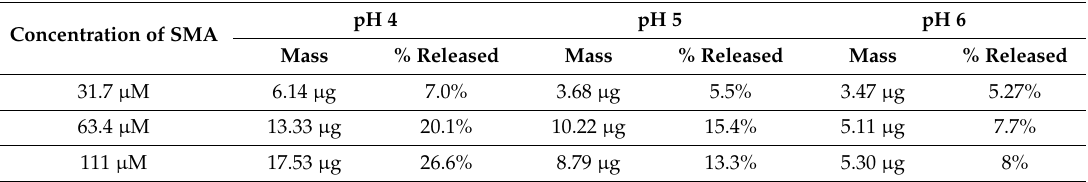
Concentration of